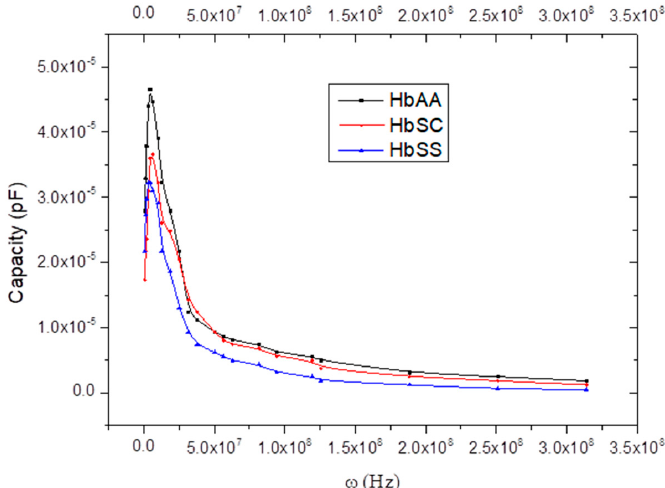
Figure 5. Comparison between HbAA (black line), HbSC (red line) and HbSS (blue line) capacity expressed in p-Farad (pF) calculated by Equation (30), as a function of frequency.